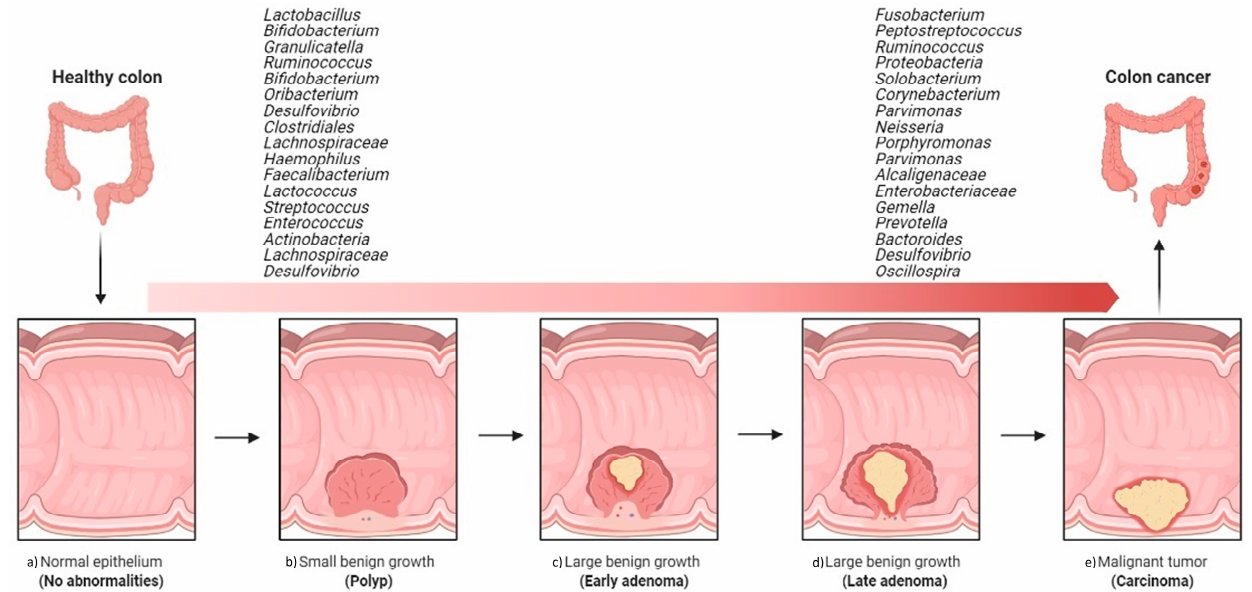
Figure 2. Overview of the implications of gut bacteria in the development and progression of colorectal cancer. Shift from healthy intestine to CRC intestine: ( a ) normal epithelium, ( b ) poly P (small benign growth), ( c ) early adenoma, ( d ) late adenoma, and ( e ) carcinoma. (The figure was created with Biorender.com).